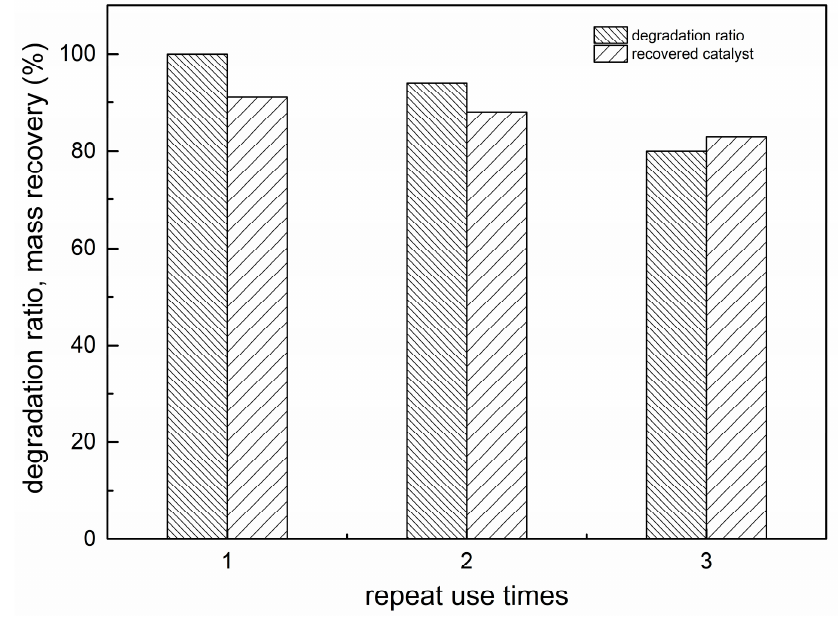
Figure 10. Performance and recovery of REC/Fe 3 O 4 /ZnO (1:0.3:0.5) during repeated use.